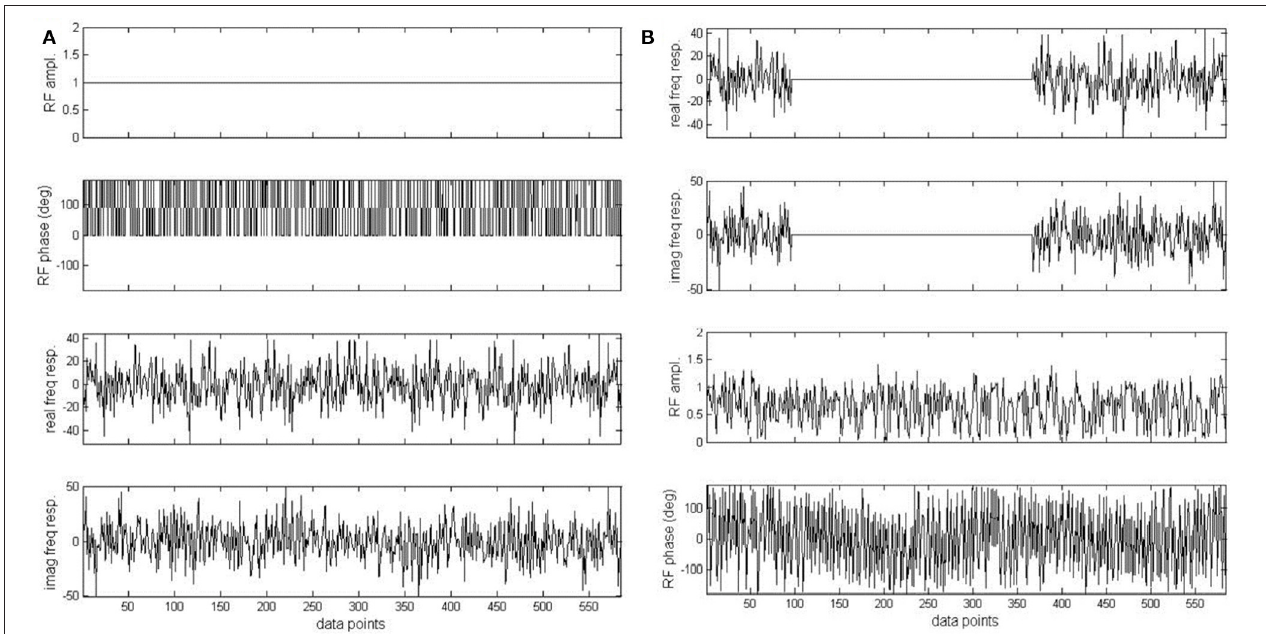
FIGURE 9 | Original pseudo stochastic decoupling sequence (A) and the windowed version (B) . Phase of the original pseudo stochastic decoupling sequence was randomly chosen to be either 0 or 180 ◦ . In (B) , the real and imaginary component of the frequency response of (A) was multiplied by an ideal double bandpass filter. The two bands correspond to the 1.91–3.90 and 6.83–7.60 ppm regions with a margin of 0.1 ppm on both sides of each band. Adapted from Xiang et al. [ 34].